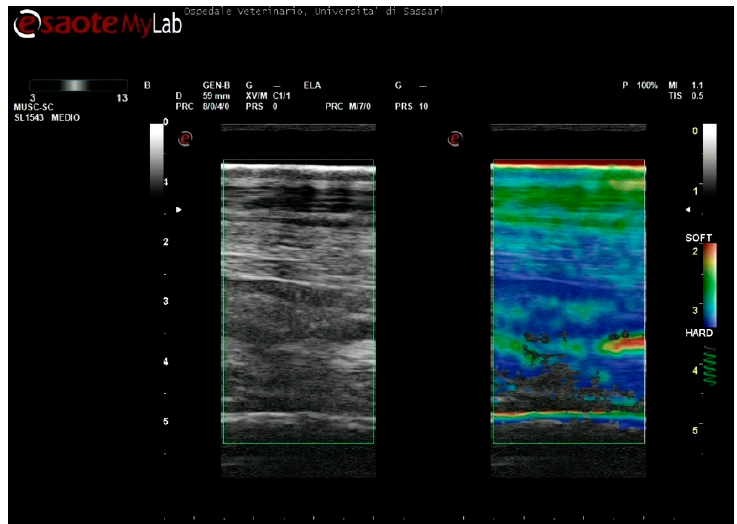
Figure 7. At the bottom of the field of view (Fov), an artifact is present as a lack of signal, without any colors. This could be explained by the use of the pad, as the deepest structures, where the artifact appears, are probably more difficult to reach, compared with images obtained without a pad. Secondly, the inclusion of a standoff pad within Fov can alter the color pattern of strain elastography-derived elastograms, because of its relativity; the standoff pad can represent the softest part within elastographic window, and as a consequence, the superficial digital flexor tendon lesions can be misinterpreted or underestimated, no longer appearing red but yellow/green.